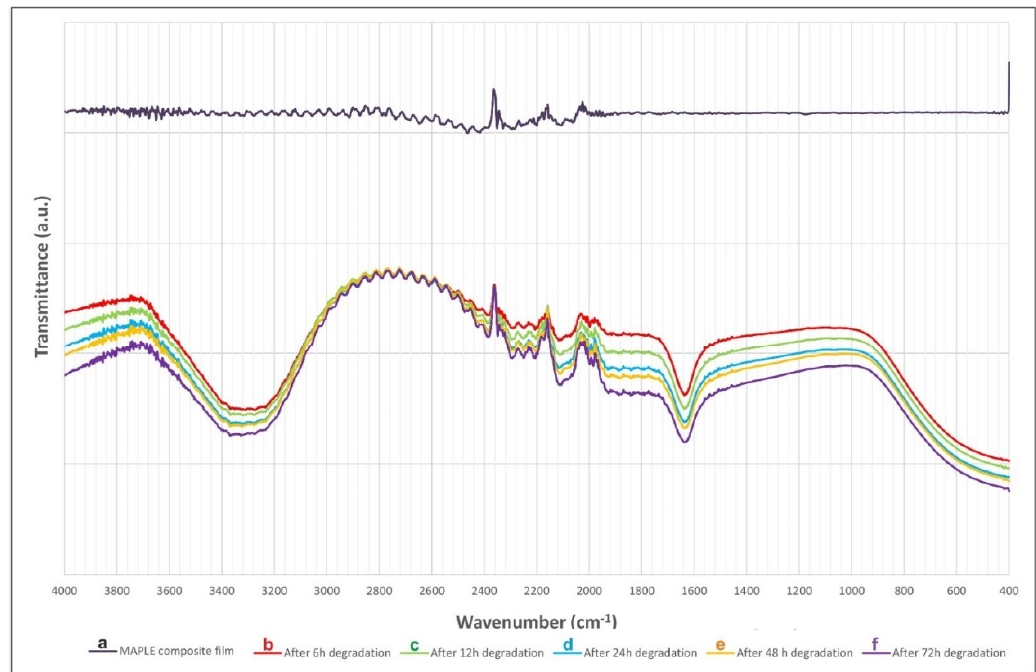
Figure 5. ATR–FTIR spectra of MAPLE coating: as-deposited ( a ) and after different degradation time intervals in SBF at 37 °C: after 6 ( b ), 12 ( c ), 24 ( d ), 48 ( e ), and 72 ( f ) hours, respectively.